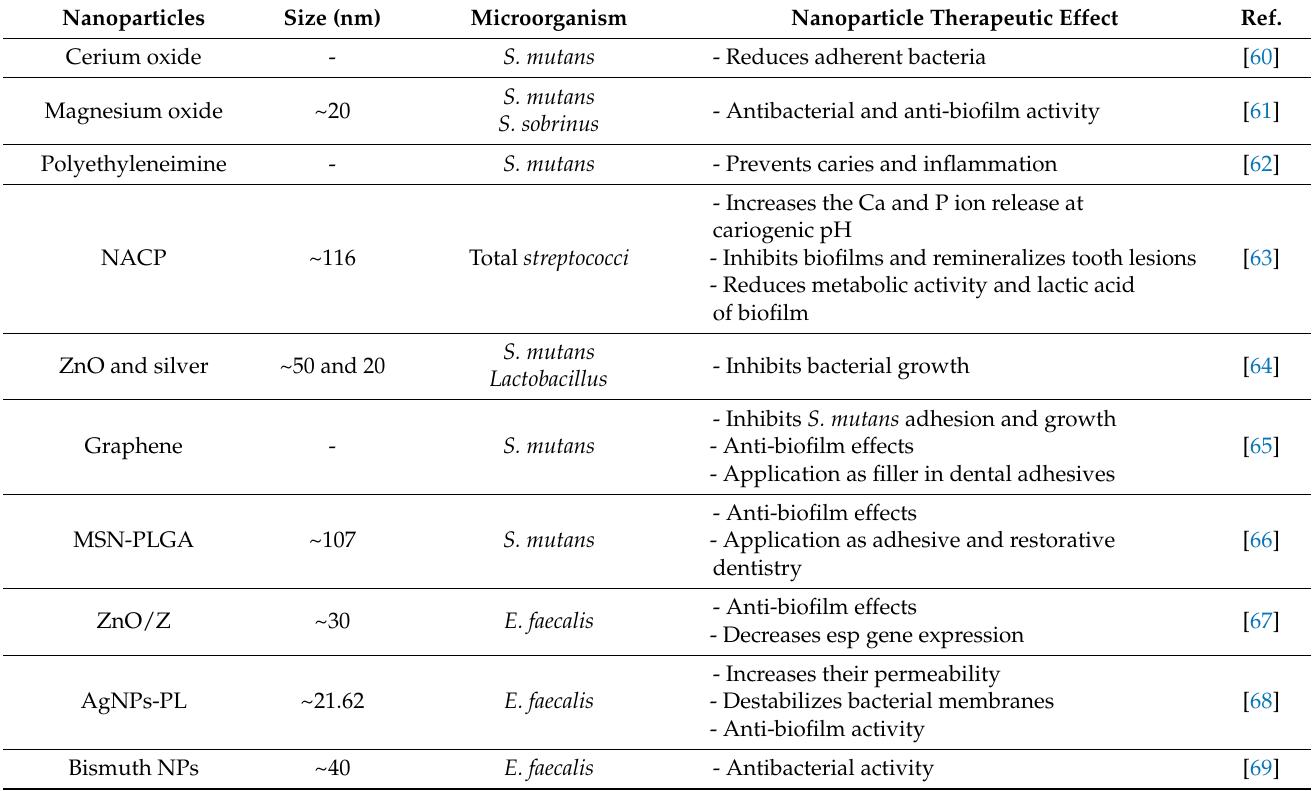
Table 1. A summary of several NPs developed for combating oral bacterial